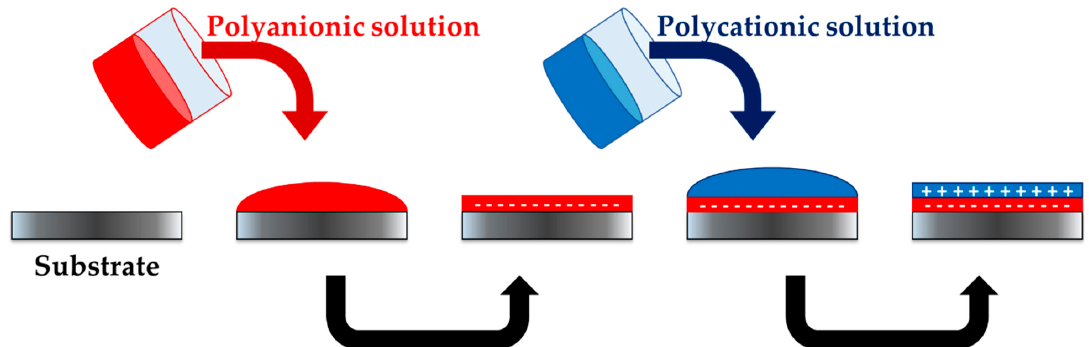
Figure 8. Process for obtaining polyelectrolyte multilayers. A solution containing a polyion is poured onto a substrate, which forms a polyionic layer. A solution containing a counter polyion is then poured onto the previously formed layers, thus forming a PEM.